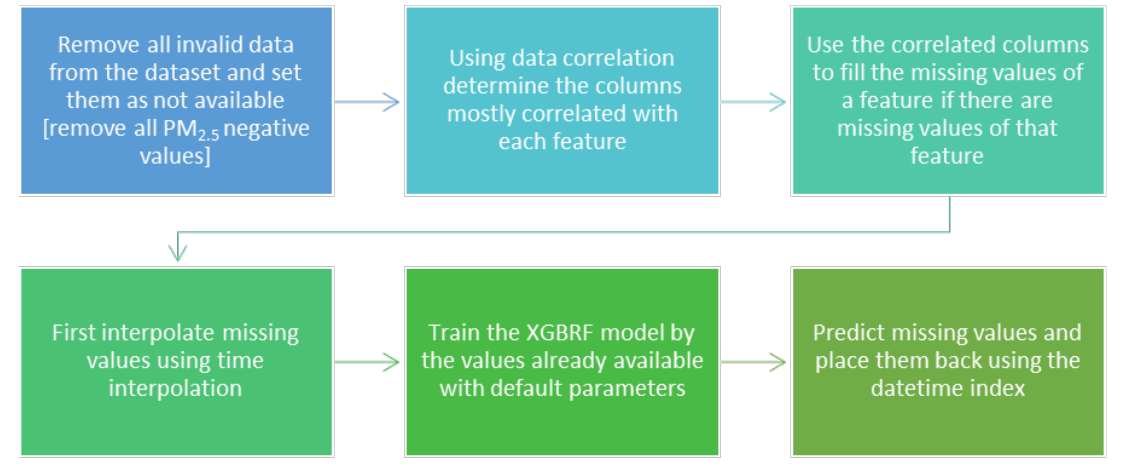
Figure 6. Sample of data from 1/5/2016 to 1/9/2016 data of Piccadilly station, Manchester, UK, before imputation.